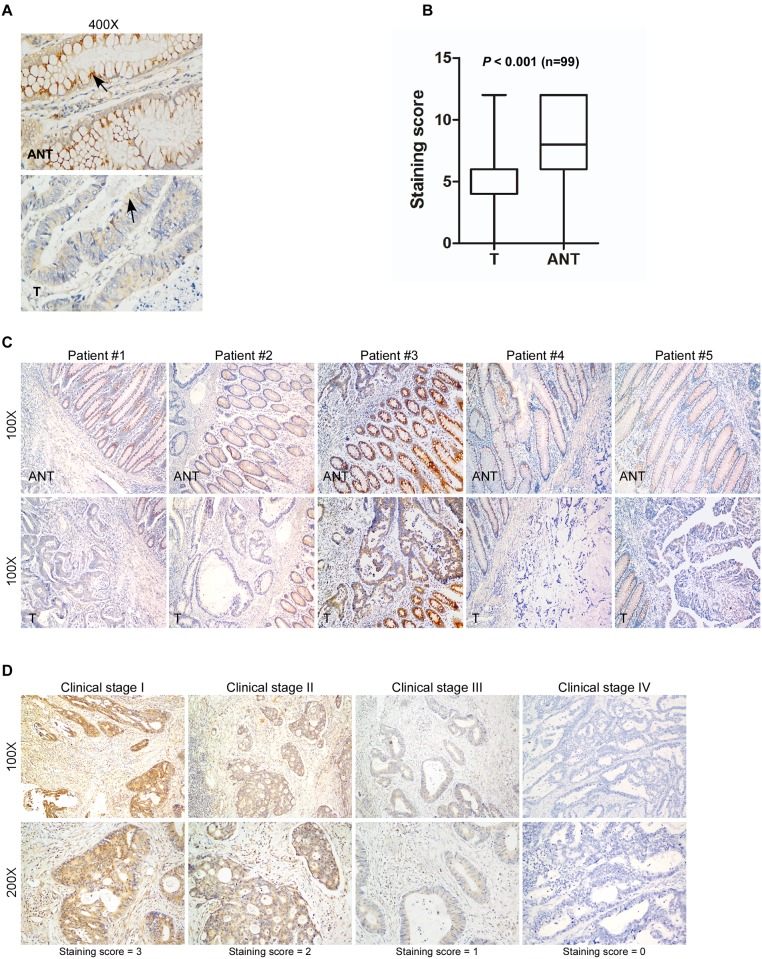
Decreased expression of DYRK2 in paraffin-embedded colorectal cancer tissues and advanced colorectal cancer.A, DYRK2 protein expressed in adjacent non-cancerous tissue (ANT) and colorectal cancer tissue (T) by IHC analysis. B, Quantitative analysis of DYRK2 expression in primary colorectal tumors and adjacent non-cancerous tissues (ANT) by IHC analysis (Wilcoxon signed rank test, n = 99, P < 0.001). C, Immuno-staining of DYRK2 in five pairs of representative colorectal tumor tissues (T) with adjacent non-cancerous tissues (ANT). D, Representative IHC analyses of DYRK2 expression at different clinical stages, two magnifications (100X and 200X).